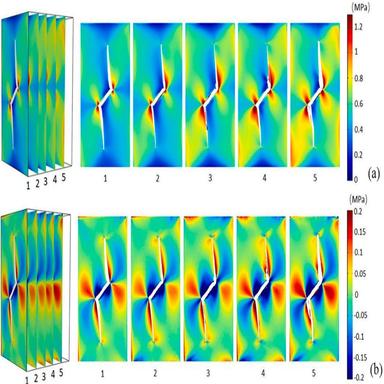
Distribution of the full-field stress at different positions when the applied load equals 0.5 MPa. (a) Principal stress difference and (b) the shear stress . The copyright permission for this figure has been granted.